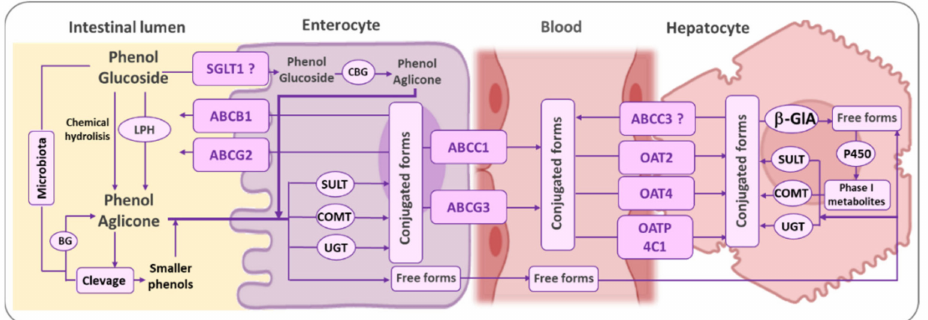
Figure 2. Illustration of the complex in vivo polyphenol metabolism. In the intestinal lumen, phenolic glucosides are hydrolyzed by lactase phloridzin hydrolase (LPH) in the brush border of the enterocyte. The phenolic aglycone is able now to enter the enterocyte, and is conjugated by uridine diphosphate glucuronosyl transferase (UGT) or sulfotransferase (SULT) enzymes. The conjugated metabolites can then be sent back to the intestinal lumen or sent into the bloodstream through several ATP- binding cassette transporters (ABC). Conjugated metabolites can be taken by hepatocytes through a series of uptake transporters (OAT transporters) and then send back to the circulatory system or they can be deconjugated in the cell by enzymes such as β -glucuronidase ( β -GlA) and suffer further metabolism before being sent to the bloodstream. BG, β -glucosidase; CBG, cytosolic BG; SCLT1, sodium-dependent glucose transporter; OAT, organic anion transporter; OATP, organic anion transporting